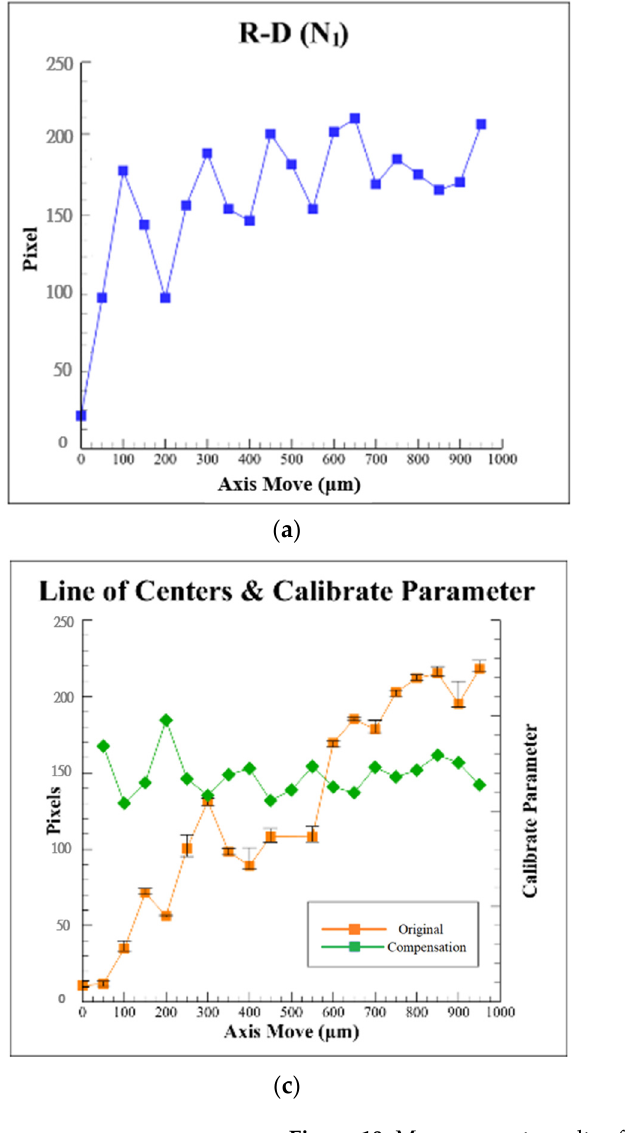
Figure 10. Measurement results of the proposed algorithm: variation of ( a ) value of R - D , ( b ) value of R / D , ( c ) compensation value, and ( d ) calibrated value with defocus distance,